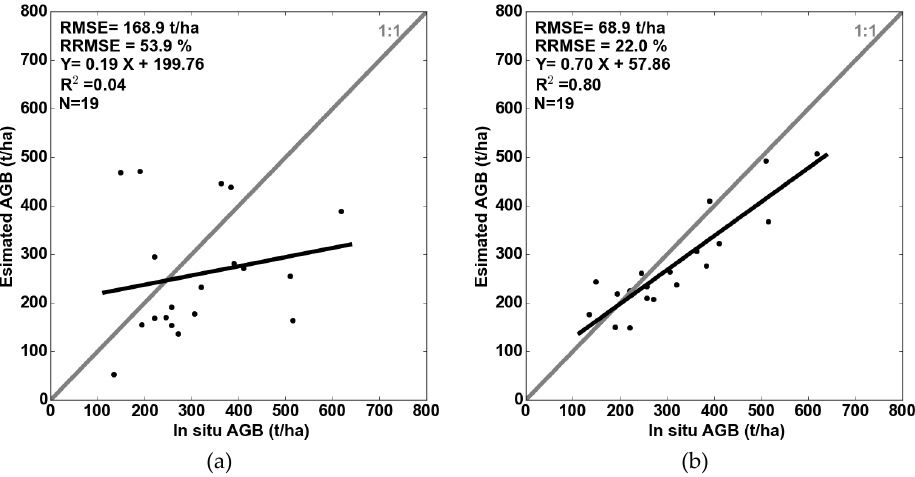
Figure 8. ( a ) Avitabile’s AGB map as a function of in situ AGB; ( b ) the improved AGB map with 1 km resolution as a function of in situ AGB. N is the number of samples used for validation.